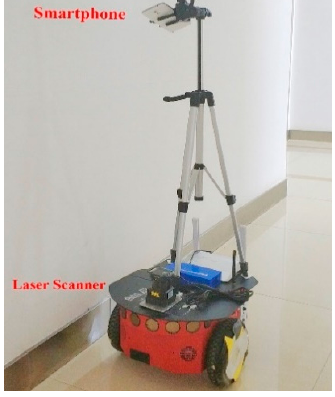
Figure 2. NAVIS hardware platform.